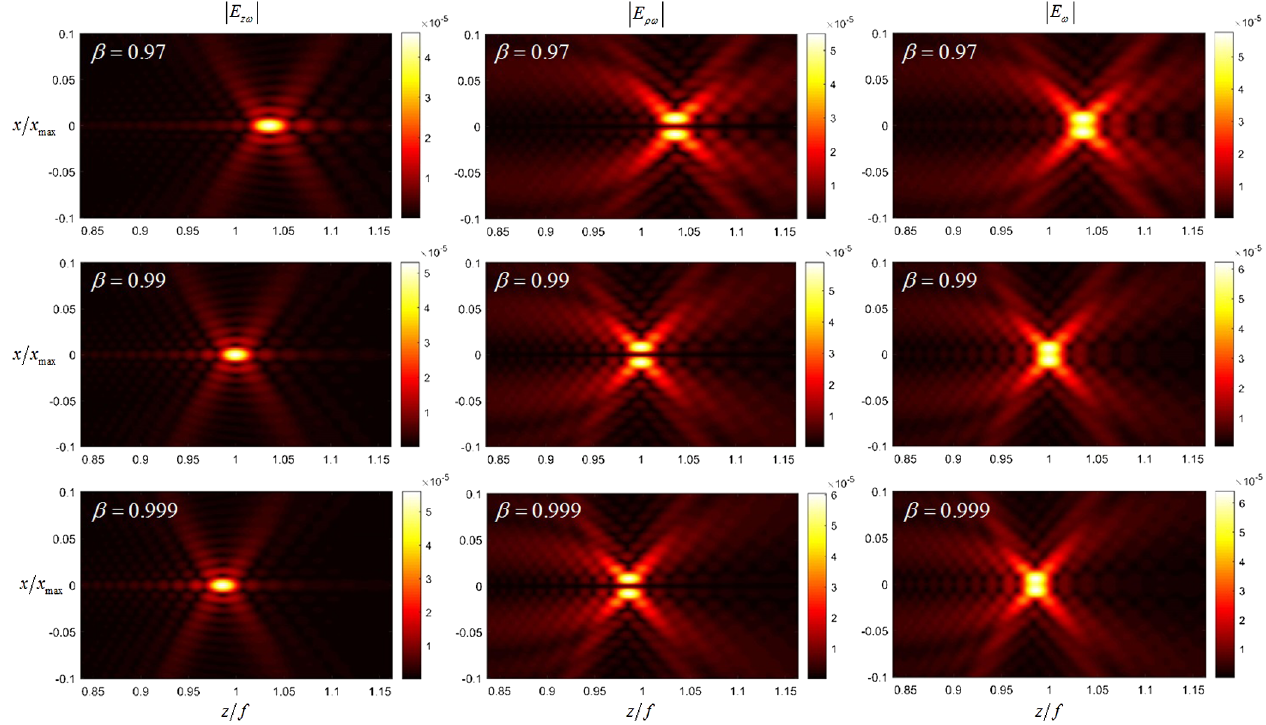
FIG. 2. Field distribution (electric field per unit frequency) over zx -plane ( x is normalized by x symmetrical case r 0 ¼ 0 and various charge velocities β : top row for β ¼ 0 . 97 , middle row for β ¼ 0 . 99 , bottom row for β ¼ 0 . 999 . Concentrator has been designed for ε ¼ 4 and β 0 ¼ 0 . 99 with the following parameters: x